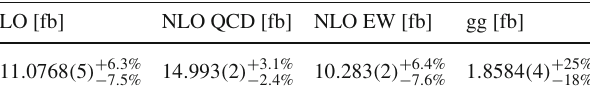
Fig. 15 Ratio between the EFT6 2 contribution to the process pp → e + ν e μ + μ − computed at NLO QCD ( σ NLO ) EFT6 2 and LO ( σ LO ) accuracy as a EFT6 2 function of the WZ transverse mass (left plot) and as a function of the transverse momentum of the muon–antimuon pair. The labels ATLAS and CMS refer to the event selections of Eq. (4.7) and (4.8), respectively. The ratio between the SM predictions at NLO QCD and at LO accuracy is also shown (black lines)